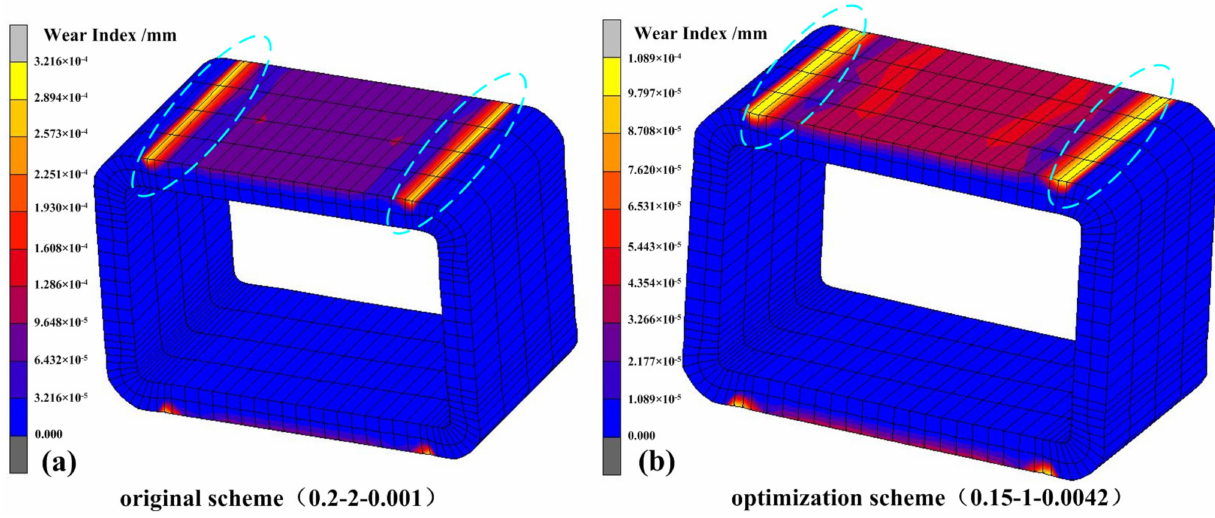
Figure 17. Simulation comparison of wear depth: ( a ) original scheme; ( b ) optimization scheme.